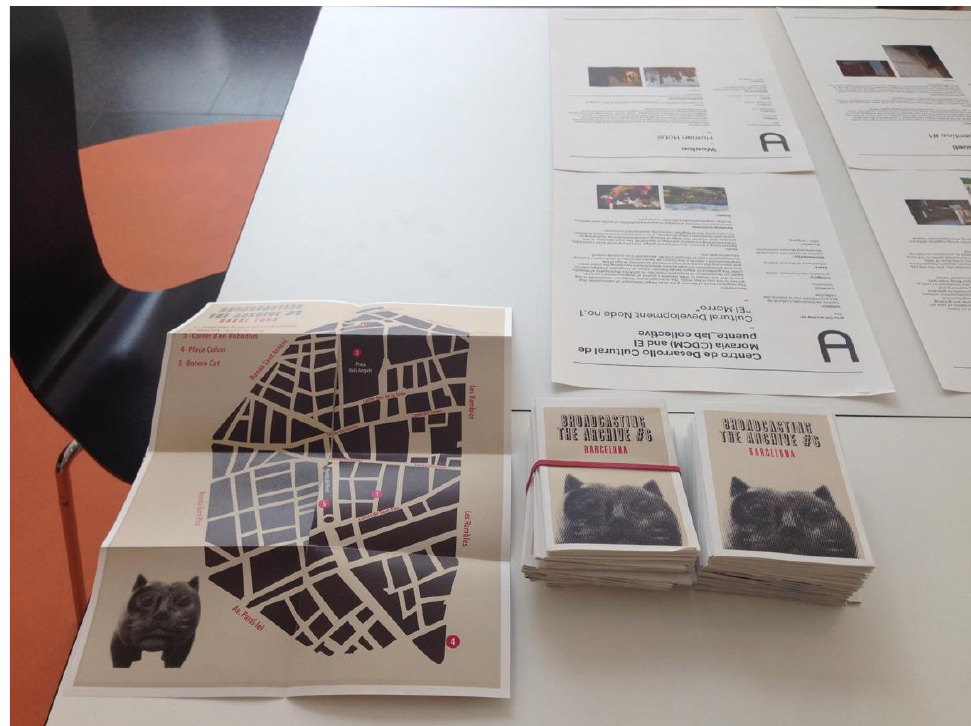
Figure 2. Broadcasting the archive #6 — Barcelona. A two-day programme realised in collaboration with Avalancha and The Umbrella Network at MACBA—Museu d’Art Contemporani de Barcelona (25 – 26 June 2016). Guests: Núria Güell, Ruben Santiago, Valentina Maini, and BioBui(L)t-Txema.